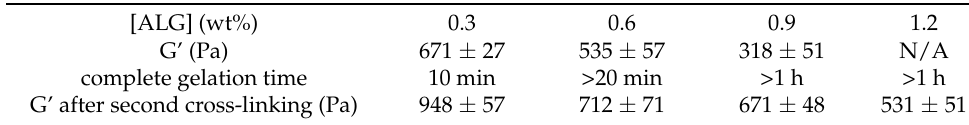
Table 1. Effect of Second Cross-Linking on Storage Shear Modulus and Gelation Time of OHA/GC/ADH/ALG Self-Healing Hydrogel. [ALG] (wt%)